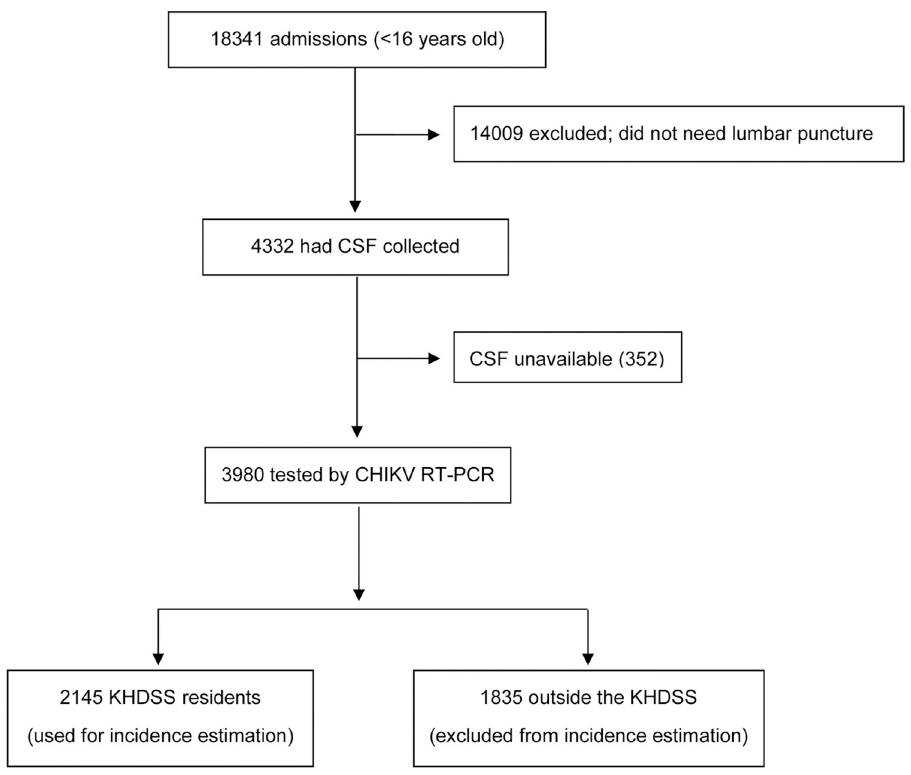
Fig 1. Flow of study participants. CHIKV AU : AbbreviationlistshavebeencompiledforthoseusedinFigs 1 and 2 : Pleaseverifythatallentriesarecorrect : , chikungunya virus; CSF, cerebrospinal fluid; KHDSS, Kilifi Health and Demographic Surveillance System; RT-PCR, reverse transcriptase polymerase chain reaction.